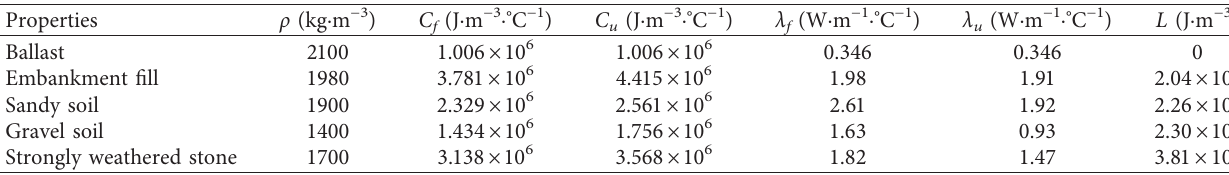
Figure 7: Physical model profile of section K1068 +750. I: ballast; II: embankment fill; III: sandy soil; IV: gravel soil; V: strongly weathered stone. Table 1: Thermal parameters of different materials in the model.